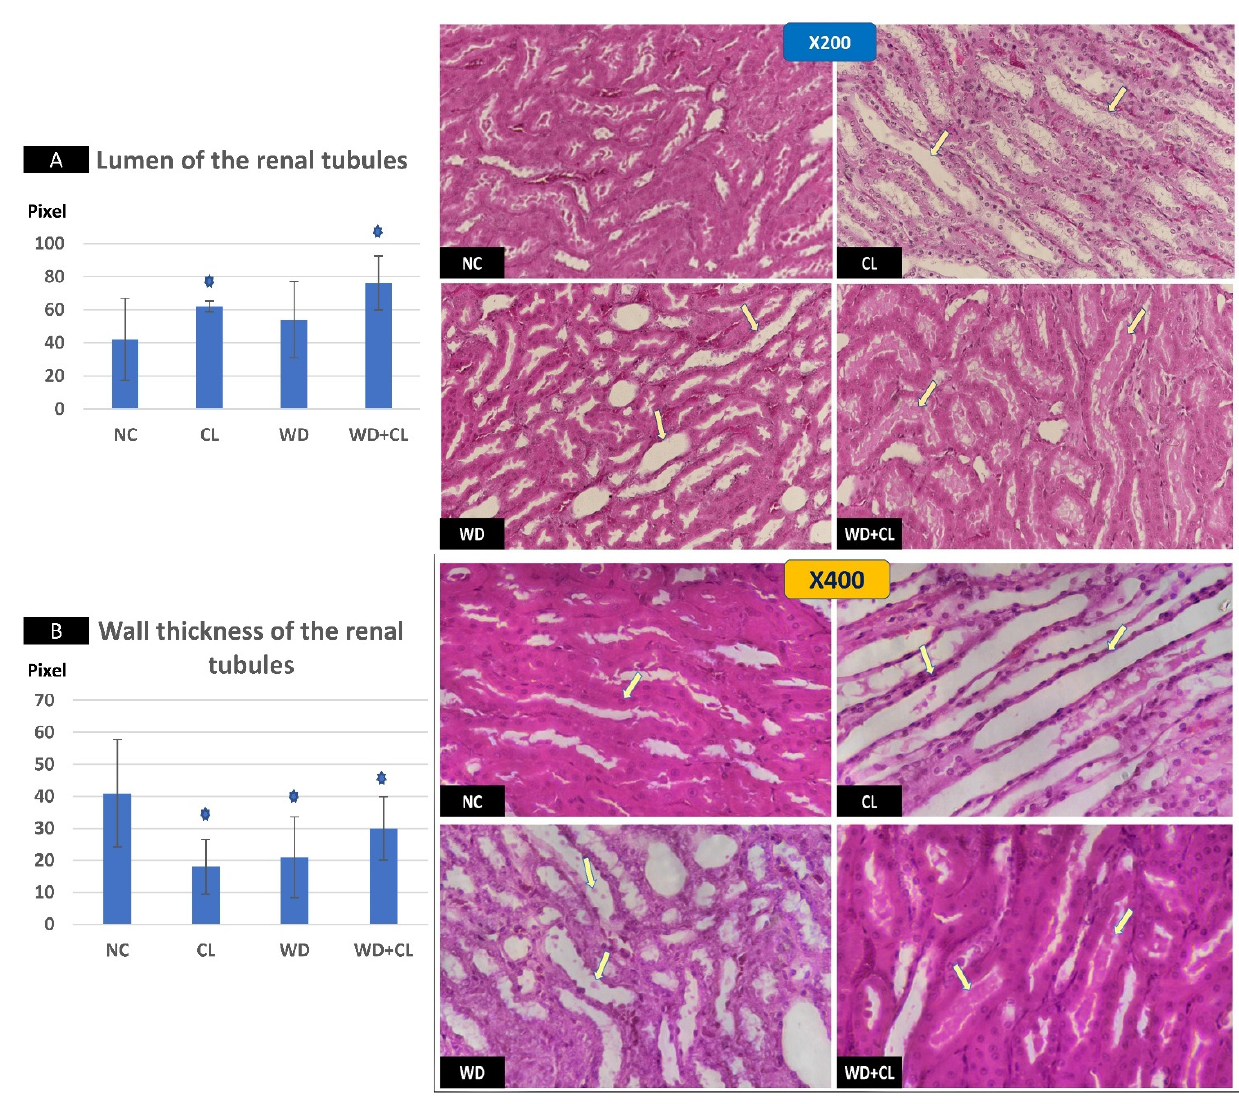
Figure 6. Sections in renal medulla showing renal tubules in different study groups at ×200 (above) and ×400 (below). The normal control (NC) section shows normal tubules. Continuous light (CL) shows dilated elongated collecting ducts filled with clear material (arrows). Western diet (WD) slide tubules were dilated with sloughed epithelium into the lumen (arrows). Combined WD + CL shows moderate dilatation with the presence of homogenous pink casts in the lumen (arrows). Compared to the NC group, the lumen of the renal tubules was dilated ( A ), and the wall-thickness was decreased ( B ). * p < 0.05. Table 3. Indirect calorimetry parameters of all studied groups (n = 8/group).